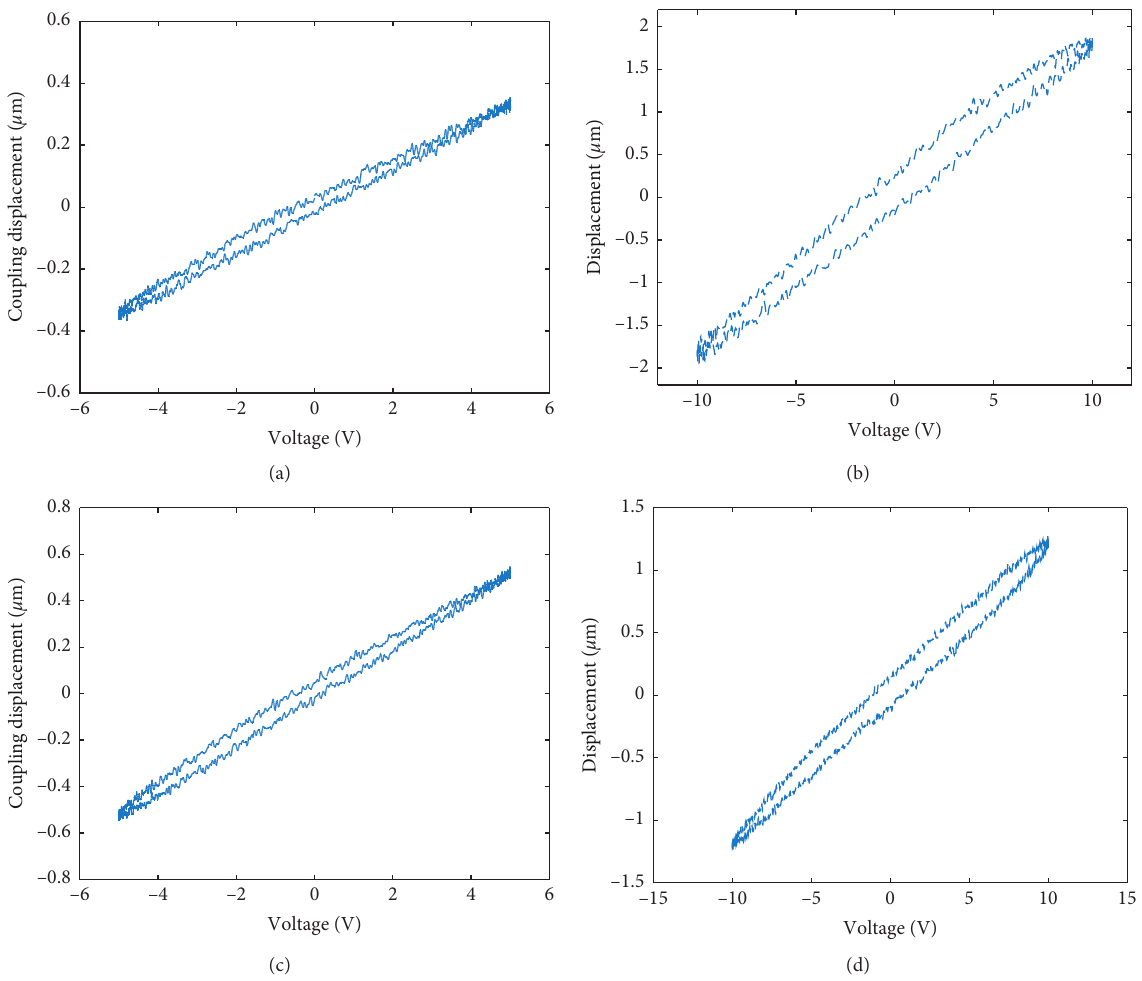
Figure 6: Hysteresis coupling between the X - and Y -direction. (a) Coupling Hysteresis in the X -direction. (b) Hysteresis displacement in the Y -direction. (c) Coupling hysteresis in the Y -direction. (d) Hysteresis displacement in the X